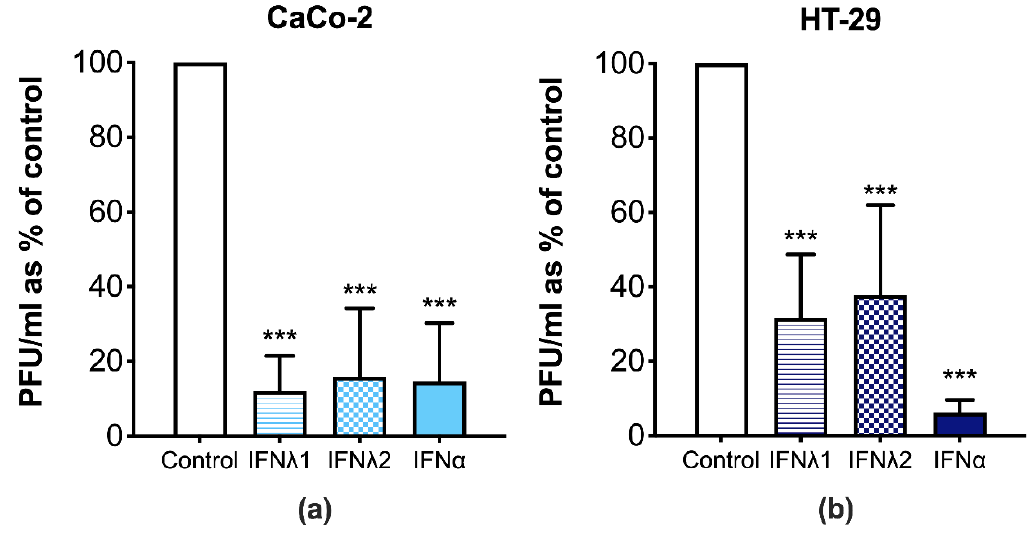
Figure 3. Type I and III interferons (IFNs) protect against Coxsackievirus B3 (CVB3) infection in intestinal epithelial cells (IECs). ( a ) CaCo-2 and ( b ) HT-29 cells were treated with vehicle, IFNλ1, IFNλ2 (both at concentration of 100 ng/mL), or IFNα (1000 U/mL) for 24 h and were then infected with CVB3 at a multiplicity of infection (MOI) of 10 −4 for 24 h. Virus titers in cells and supernatants were measured 24 h p.i. by standard plaque assay. Data are presented as the mean plaque forming units (PFUs) ± SD from at least four independent experiments per cell line. Significant decreases in virus titers were observed in all treatments when compared to the vehicle alone (*** p < 0.001; one-way ANOVA).